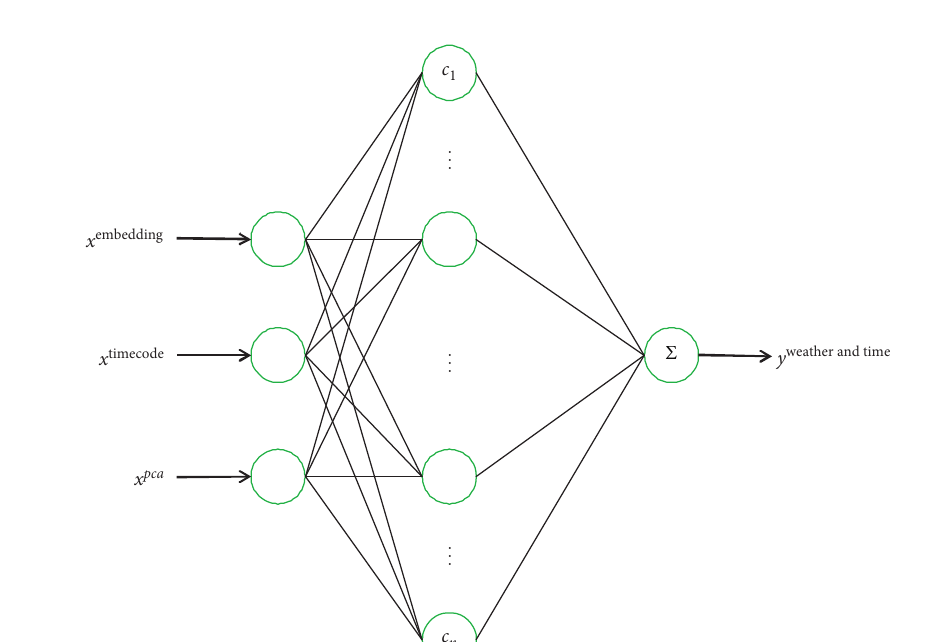
Figure 5: SAE structure in